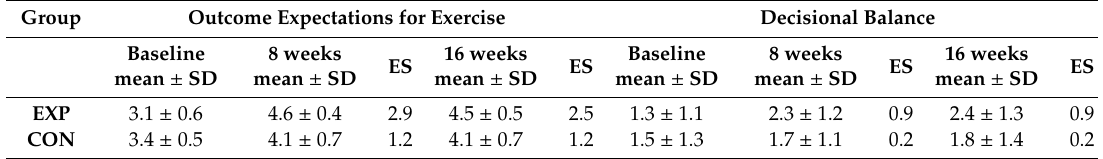
Table 5. Differences between adherence to exercise programs in the low and high group based on the baseline score in questionnaires.